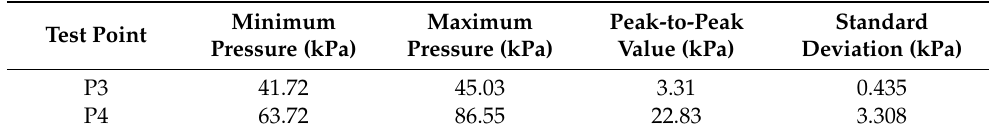
Table 2. Pc = 2.57 MPa. Data statistical analysis results.